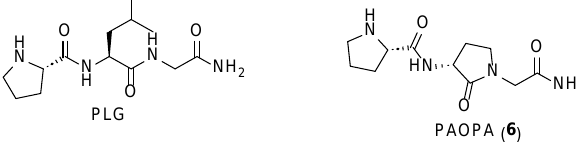
Figure 6. Chemical structures of PLG and PAOPA.